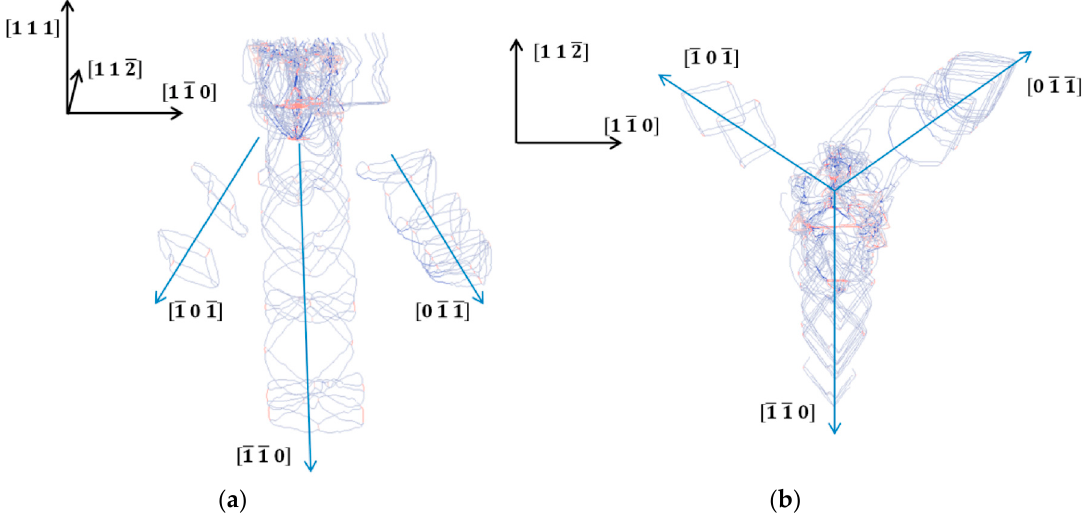
Figure 17. Prismatic loops forming and movement in Ni thin film indented by the cylindrical indenter during nanoindentation: ( a ) side view and ( b ) top view (after Voyiadjis and Yaghoobi [86]).